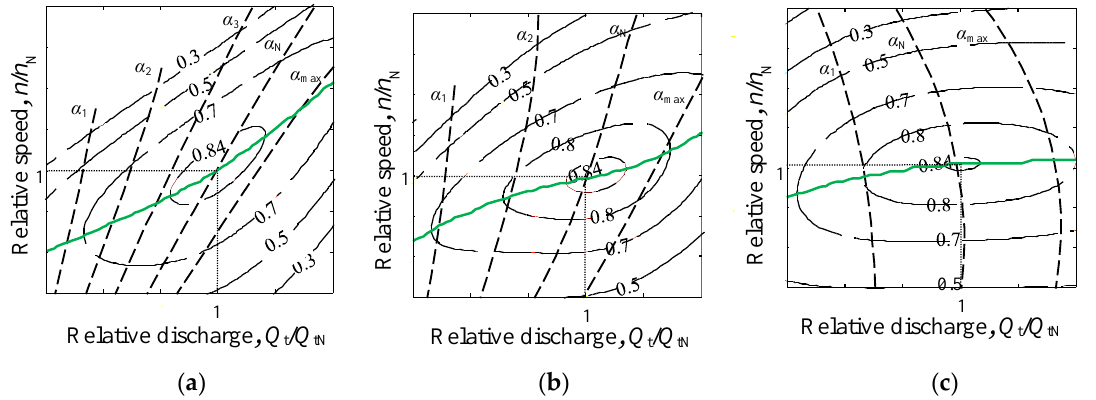
Figure 2. Hill charts of a ( a ) fast turbine, ( b ) normal turbine, and ( c ) slow turbine showing the optimal operating curve (green solid line).